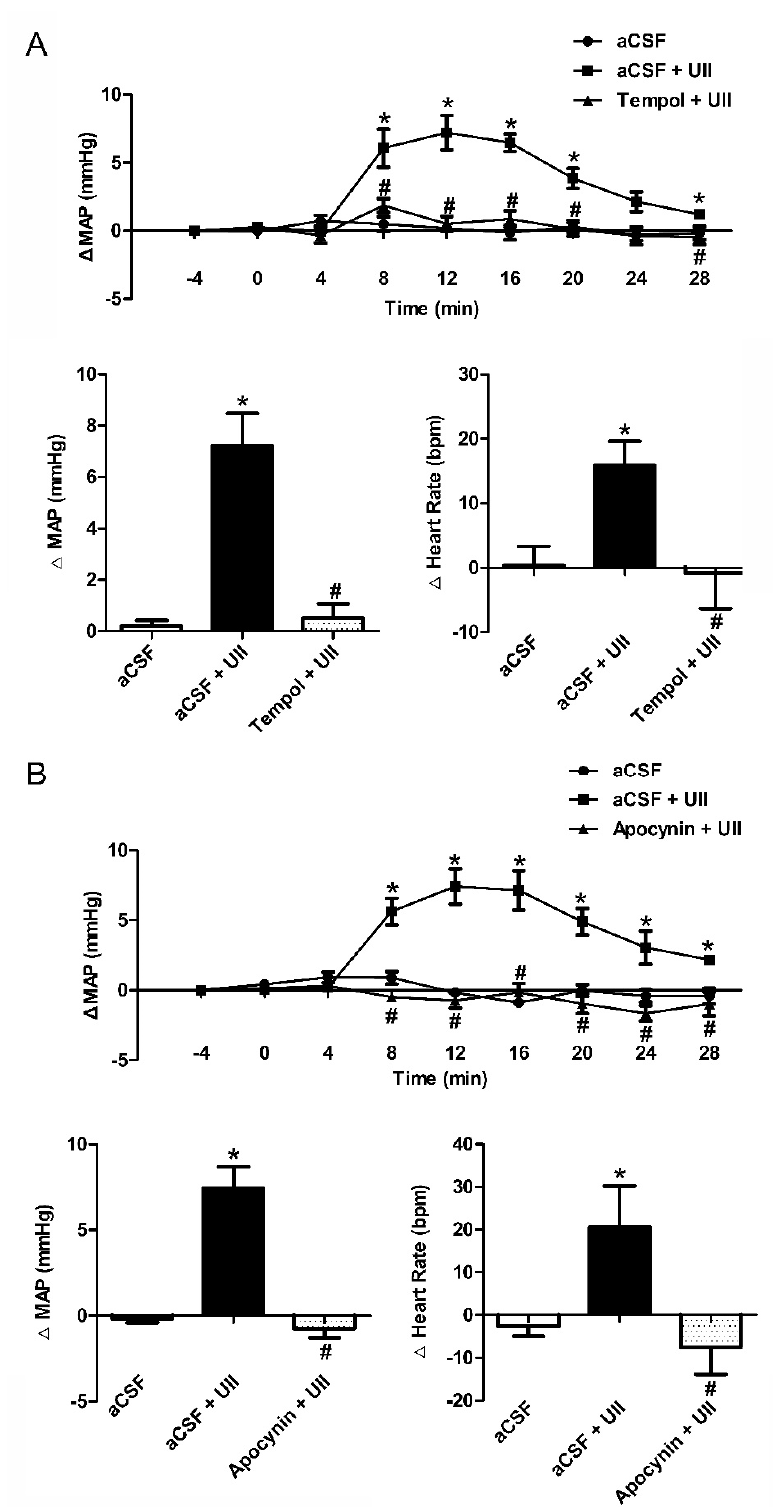
Figure 6. Microinjection of Tempol (a superoxide dismutase mimic) or Apocynin (NADPH oxidase inhibitor) into the RVLM decreased MAP and HR in SD rats. Time course of MAP in response to microinjection of aCSF ( n = 6), aCSF + UII ( n = 6), or Tempol (50 nmol/0.1 µ L, ( A ))/Apocynin (5 nmol/0.1 µ L, ( B )) + UII ( n = 6, 6) and the maximal changes detected during the response. * p < 0.05 vs. aCSF group; # p < 0.05 vs. aCSF + UII group.